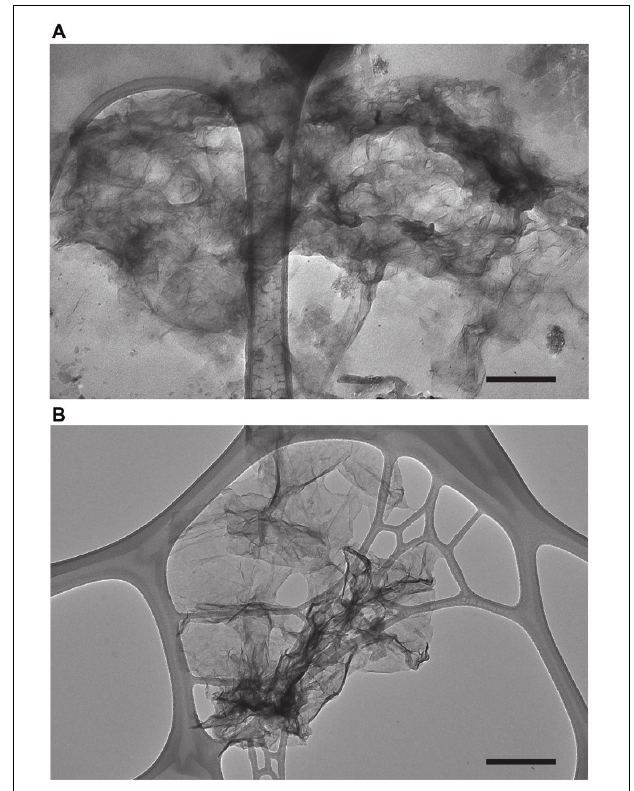
FIGURE 4 | Transmission electron microscopy images of Mn oxides produced under experimental conditions (water from the western basin amended with Mn and catalase) (A) and water from the hypoxic hypolimnion of Lake Erie (central basin) (B) . The scale bar (black bar) is 250